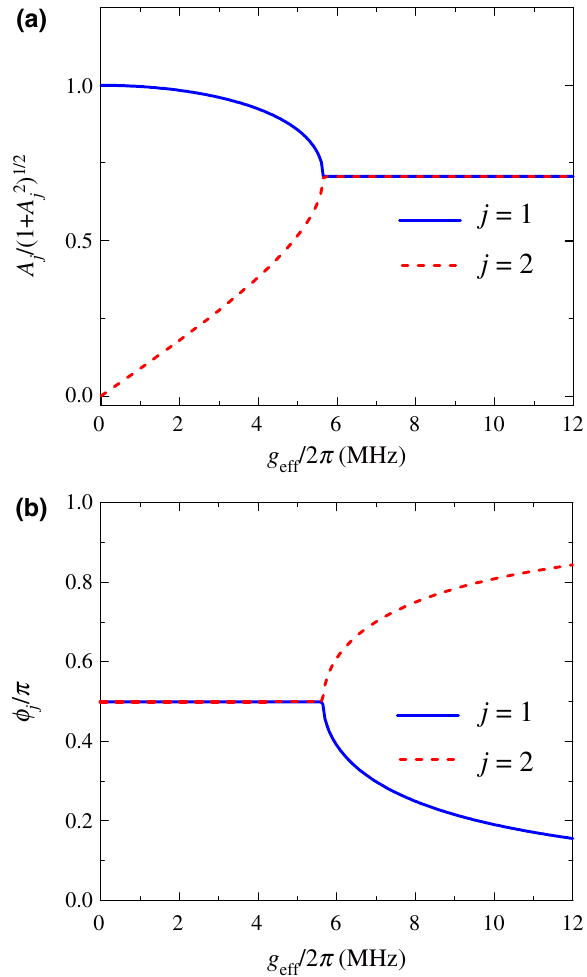
FIG. 6. The effective-coupling dependence of the param- eters of the eigenvector. (a) The normalized amplitudes (cid:6) 1 + A 2 and (b) the relative phases φ 1,2 /π of the two A 1,2 / 1,2 eigenvectors versus the effective coupling strength g eff / 2 π . Here, we choose κ/ 2 π = 0.6 MHz and γ/ 2 π = 11.9 MHz, as in the main